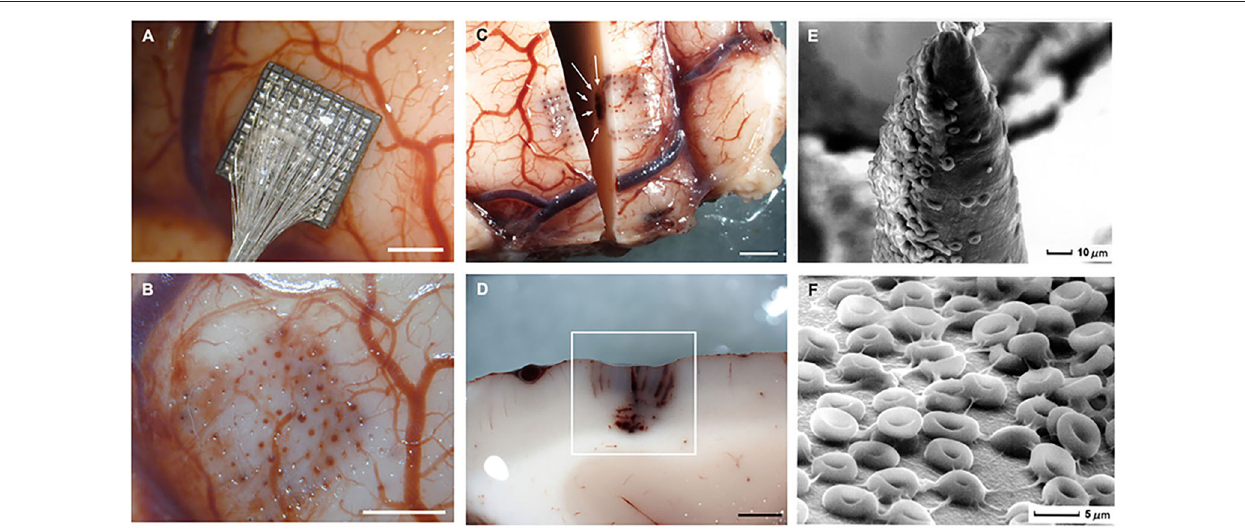
FIGURE 3 | Gross specimens of human temporal lobe implantations and micrographs of the surface of the Utah electrode array after acute implantation in human brain. (A) Placement of an electrode array in temporal cortex. (B) Once the array has been removed there are some evident microhemorrhages. (C) Horizontal section showing blood in the outermost electrode tracks and petechial hemorrhages (white arrows) located below the tip of the electrodes. (D) Detail of the petechial hemorrhages. (E) Scanning electron micrograph of an electrode tip. Many red blood cells appear in close contact with electrode materials. (F) Detail of the red blood cells on the surface of the microelectrodes. Calibration bars (A–D) = 2mm. Figure and caption reprinted from Fernández et al. (2014). Microhemorrhages such these are associated with acute neuroinflammation and transient disruption of signal